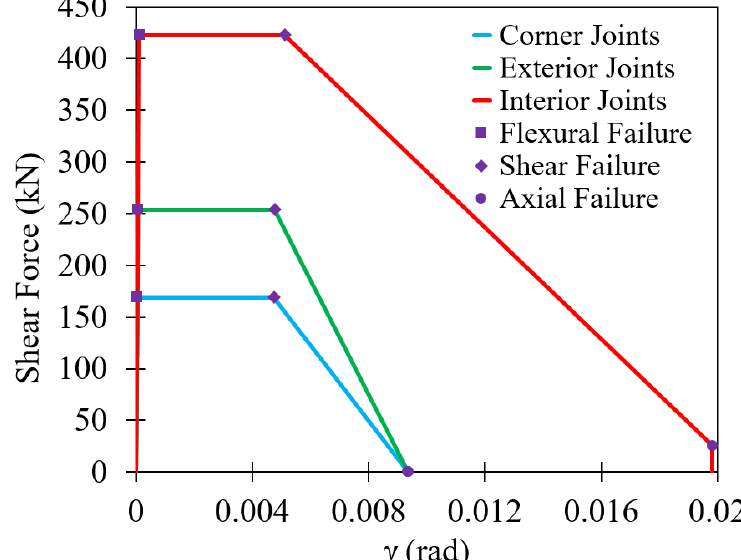
Fig. 6. Shear Force Vs. Rotation of the joints for the model with P/Ag.f'c =0.12 (ASCE/SEI